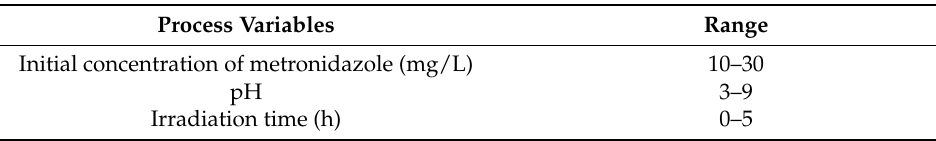
Table 2. Process variables and their variation range.